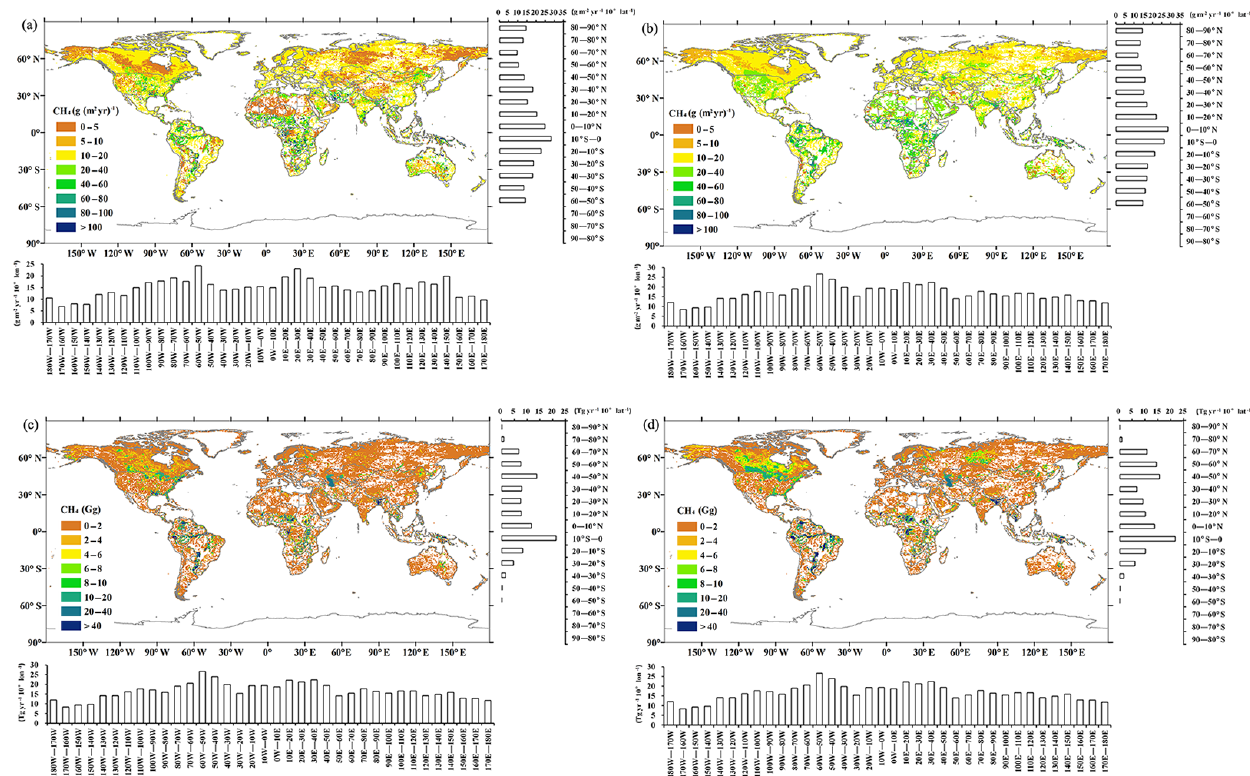
Figure 5. Spatial pattern of annual mean CH 4 fluxes for 2000–2010, with latitudinal and longitudinal distributions of annual mean CH 4 fluxes by CH4MOD wetland (a) and TEM (b) . Spatial pattern of annual mean CH 4 emissions for 2000–2010, with latitudinal and longitudinal distributions of annual mean CH 4 emissions by CH4MOD wetland (c) and TEM (d) . The CH 4 fluxes and emissions are aggregated in steps of 10 ◦ .